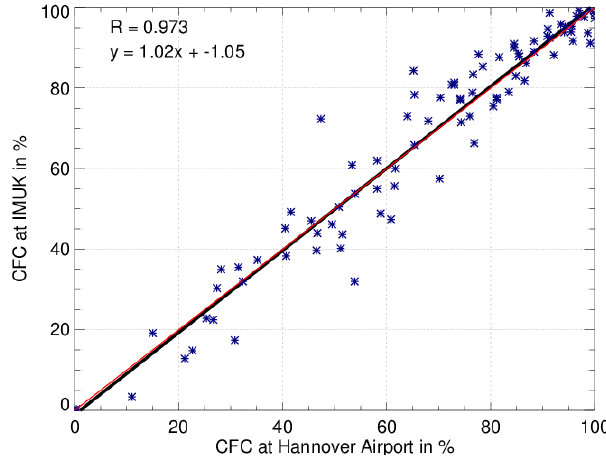
Figure 5. Relation between instantaneous SEVIRI cloud fractional cover (CFC) of pixels over Hannover Airport (HAJ) and the Insti- tute of Meteorology and Climatology (IMUK).